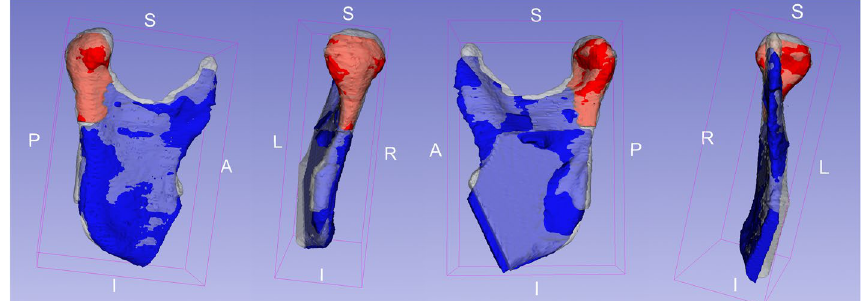
Fig. 3 A 3D printed model of the STL-files in different